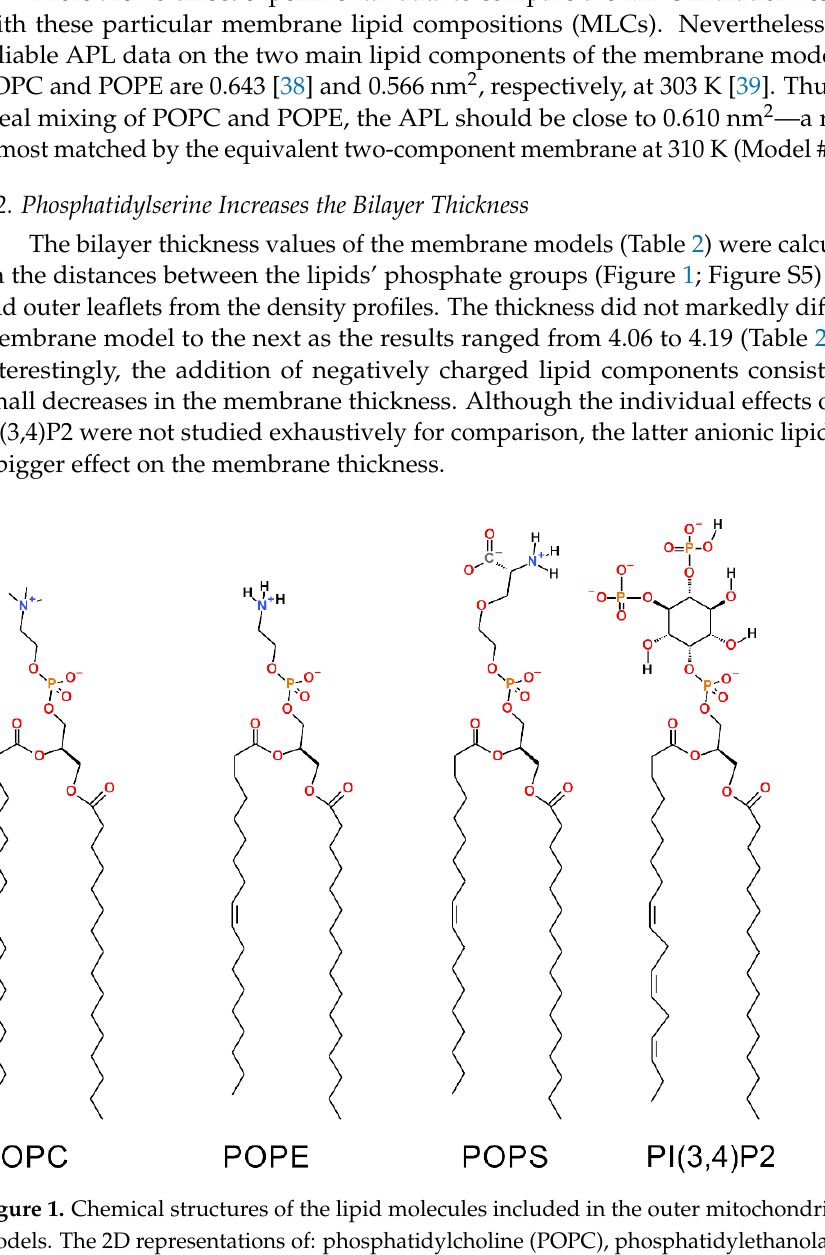
Table 2. Area per lipid, membrane thickness, charge carried by bilayer, and surface charge density .